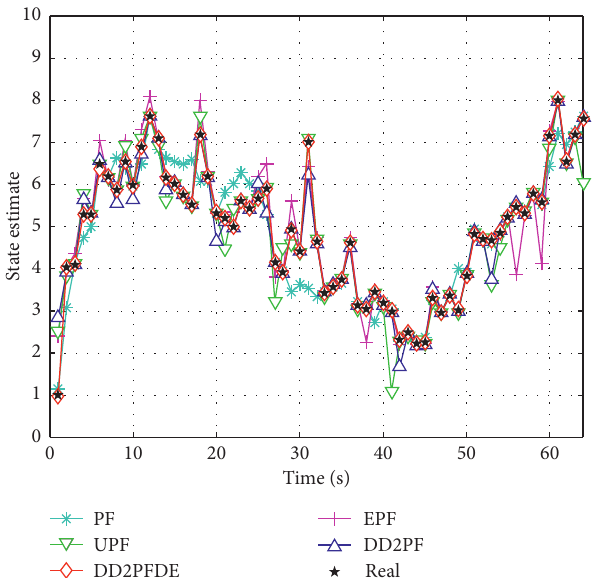
Figure 2: Filtering result comparison of five filters in a random simulation run, where particle numbers N � 10.